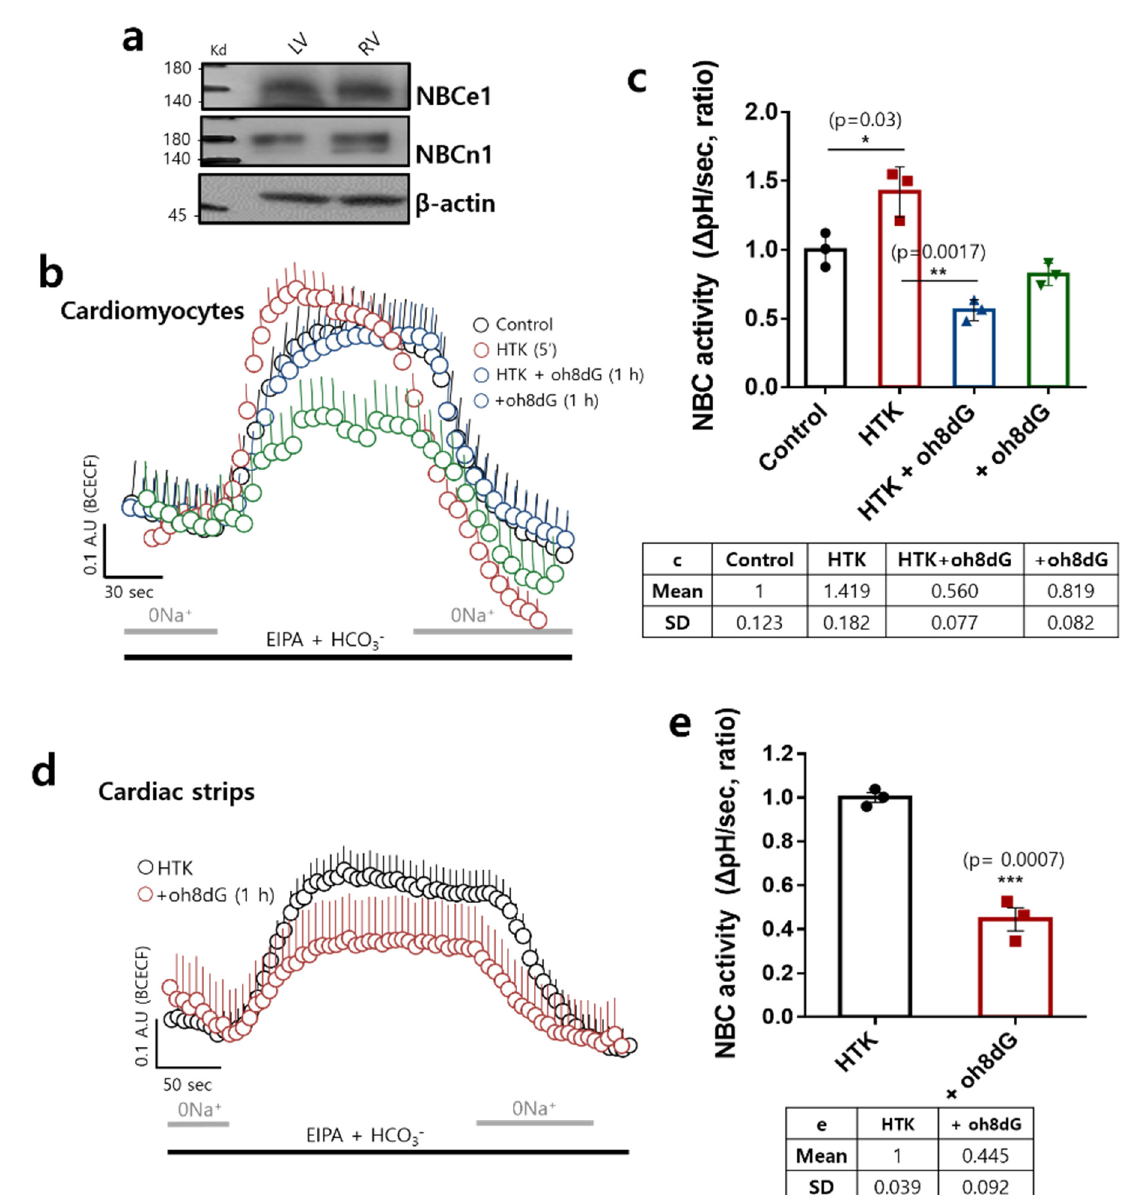
Figure 3. HTK-exposed cardiac tissues enhanced NBC activity, attenuated by the treatment of oh8dG. ( a ) Protein expression of NBCe1 and NBCn1 in left and right ventricle (LV and RV, respectively) cardiac strips of mice ( n = 6). β -actin was used as the loading control. ( b ) NBC activity was assessed by measuring changes of pH i with or without pre-incubation of 100 µ g/mL oh8dG for 1 h in